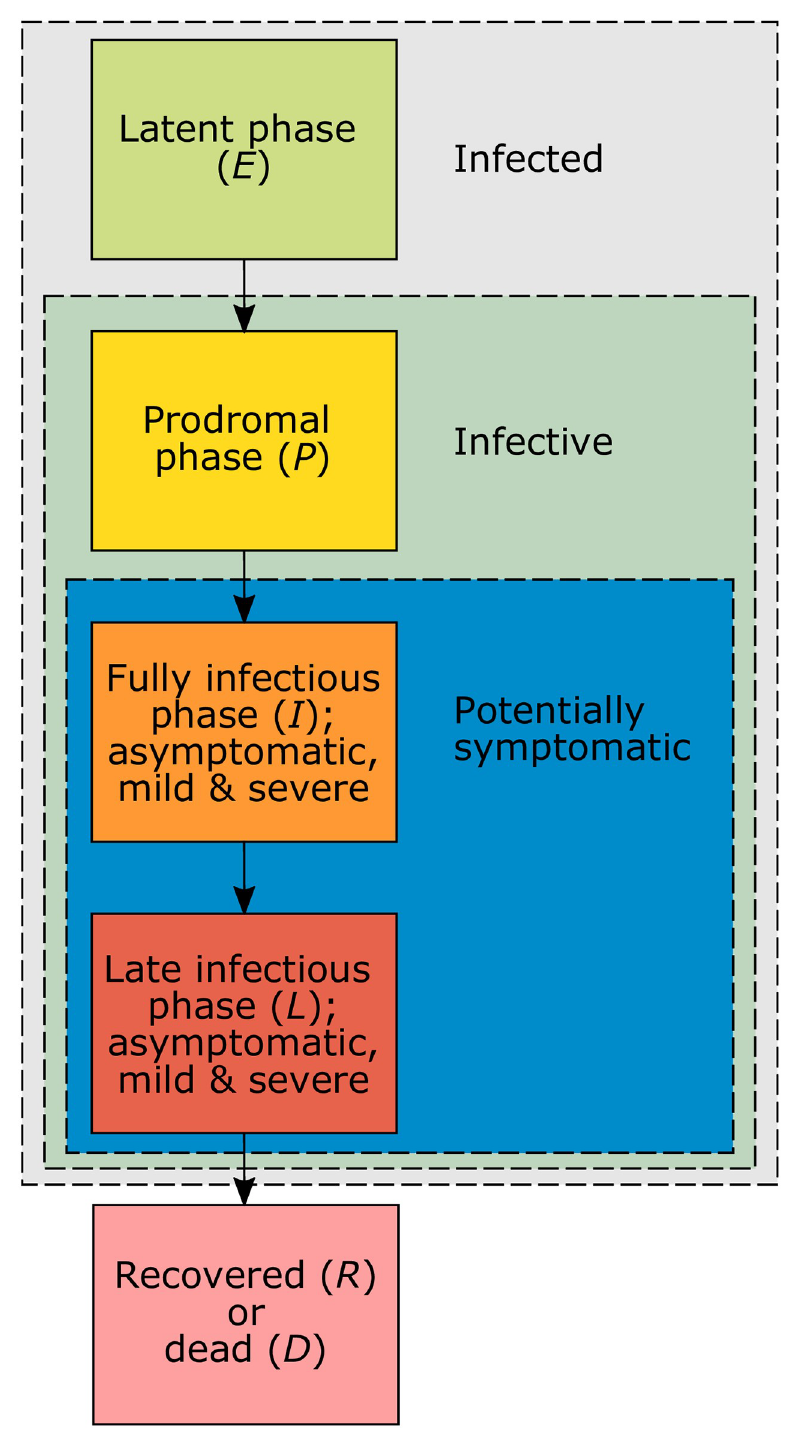
Fig 1. Phases of the infection. Schematic representation of the disease phases and at which stages individuals become infective and potentially symptomatic.